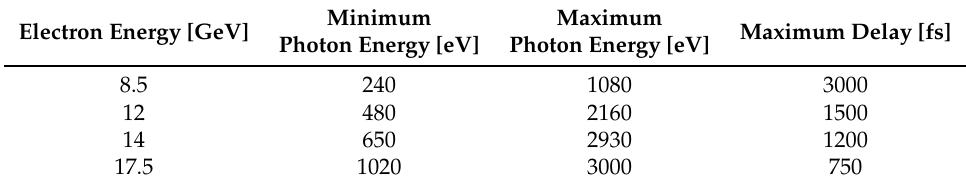
Table 1. Available photon energies in the SASE3 undulator for different electron beam energies, and corresponding temporal delays between two pulses (see also Figure A2 in Appendix